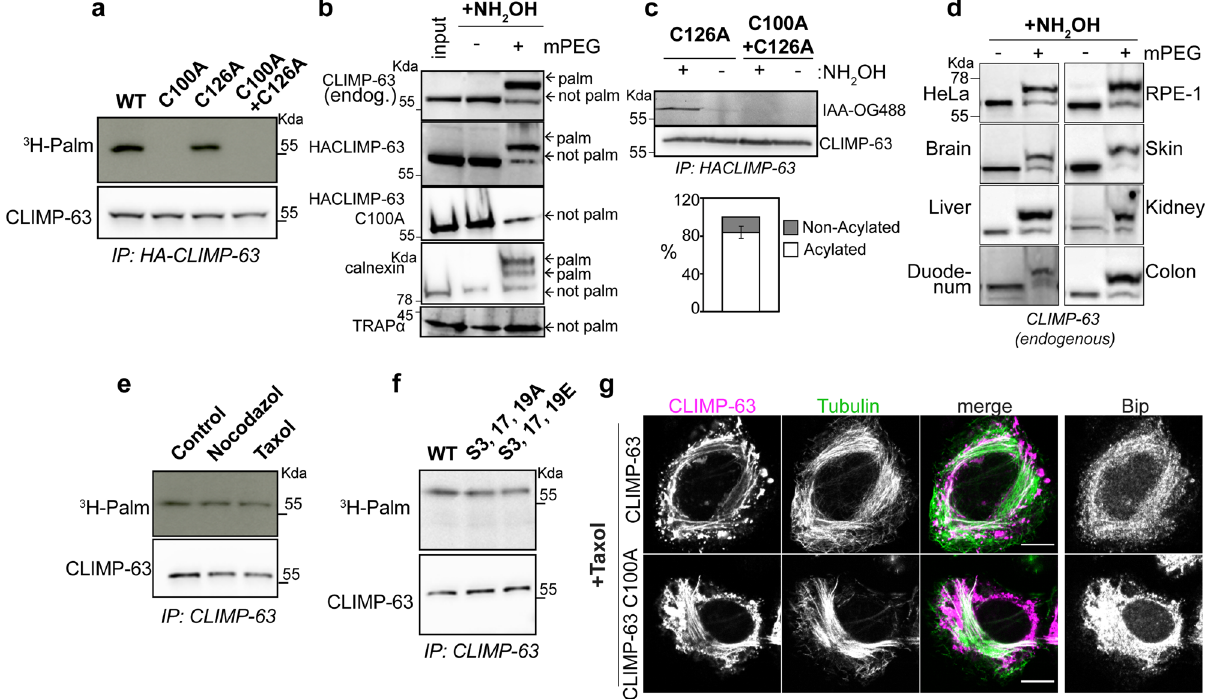
Fig. 1 | The bulk of CLIMP-63 is S-palmitoylated in vitro and in vivo. a 3 H-palmitate labelling of shCLIMP-63 HeLa cells expressing HA-CLIMP-63 WT, C100A, C126A or C100A-C126A mutants. Western blot and autoradiography show 3 H-palmitate in HA-CLIMP-63 immunoprecipitation fractions (IP: HA-CLIMP-63). b PEG-labelling(+mPEG)wasperformed,ornot(-mPEG)onendogenousCLIMP-63, transfected HA-CLIMP-63 WT or C100A mutant, endogenous calnexin and TRAP- alphafollowingtreatmentofHeLalysateswithhydroxylamine(NH2OH).Theinput corresponds to same amount of protein present in each condition. c Non-acylated fractionofCLIMP-63.LysatesfromshCLIMP-63HeLacellsexpressingHA-CLIMP-63 C126A or C100A+C126A were treated or not with NH2OH and labelled with iodoacteamide-oregon-green-488 (IAA-OG488) as described in Supplementary